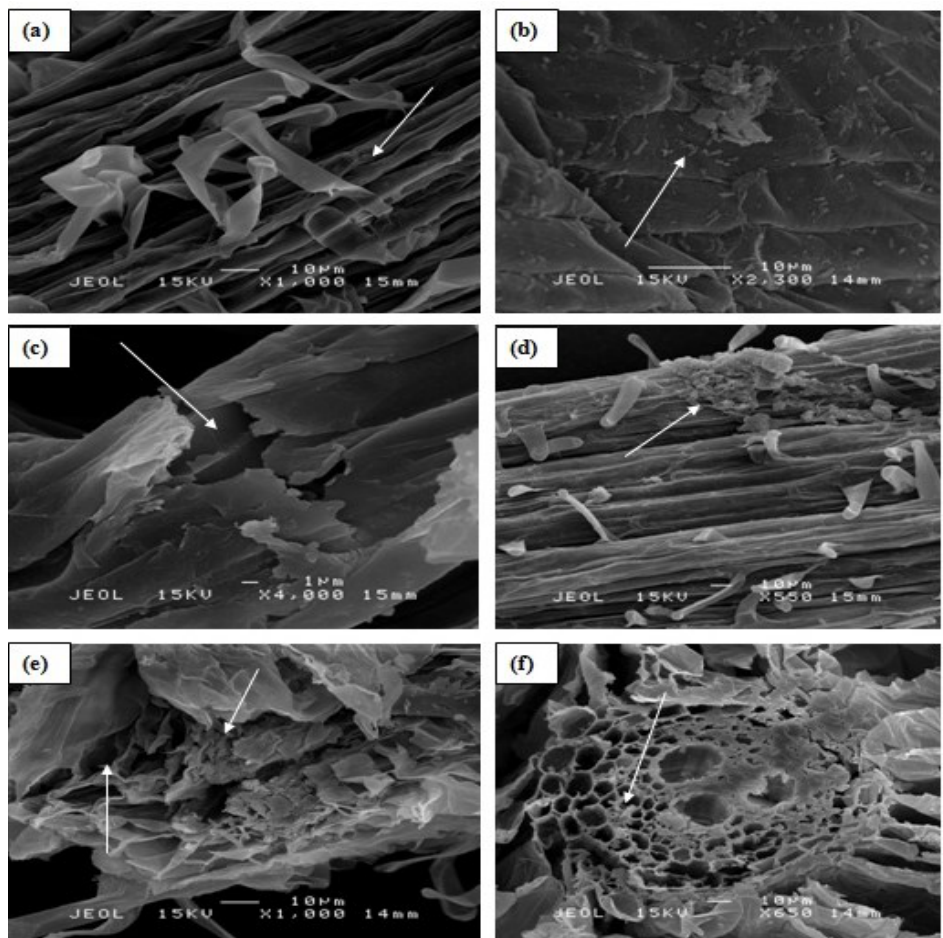
Figure 4. Scanning electron micrographs showing the effects of Al toxicity in rice roots: ( a ) root surface in the control treatment at 0 µM Al, arrow shows no rupturing and microbes presence ( b ) PGPB inoculated root surface at 0 µM Al, arrow shows the microbes on the root surface ( c ) showing root cracks and tearing of the cells in the rhizodermis and outer cortex resulting in the formation of transverse ruptures in the control treatment at 100 µM Al, ( d ) showing PGPB inoculated root surface at 100 µM Al, arrow shows the microbes on the root surface ( e ) showing the effects on the root cortical tissues in the control treatment at 100 µM Al, arrows indicate the distance of a rupture at the interior- and exterior-surface of an individual cell and ( f ) showing root cortical tissues inoculated with PGPB at 100 µM Al concentration, arrow indicates microbes in the root cortical